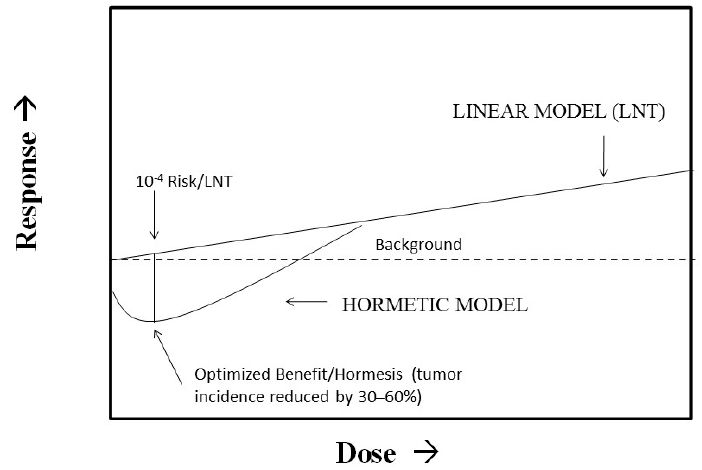
Figure 1. Integration of hormesis and LNT (linear non-threshold) for risk assessment. (Source: Calabrese et al. [52]).